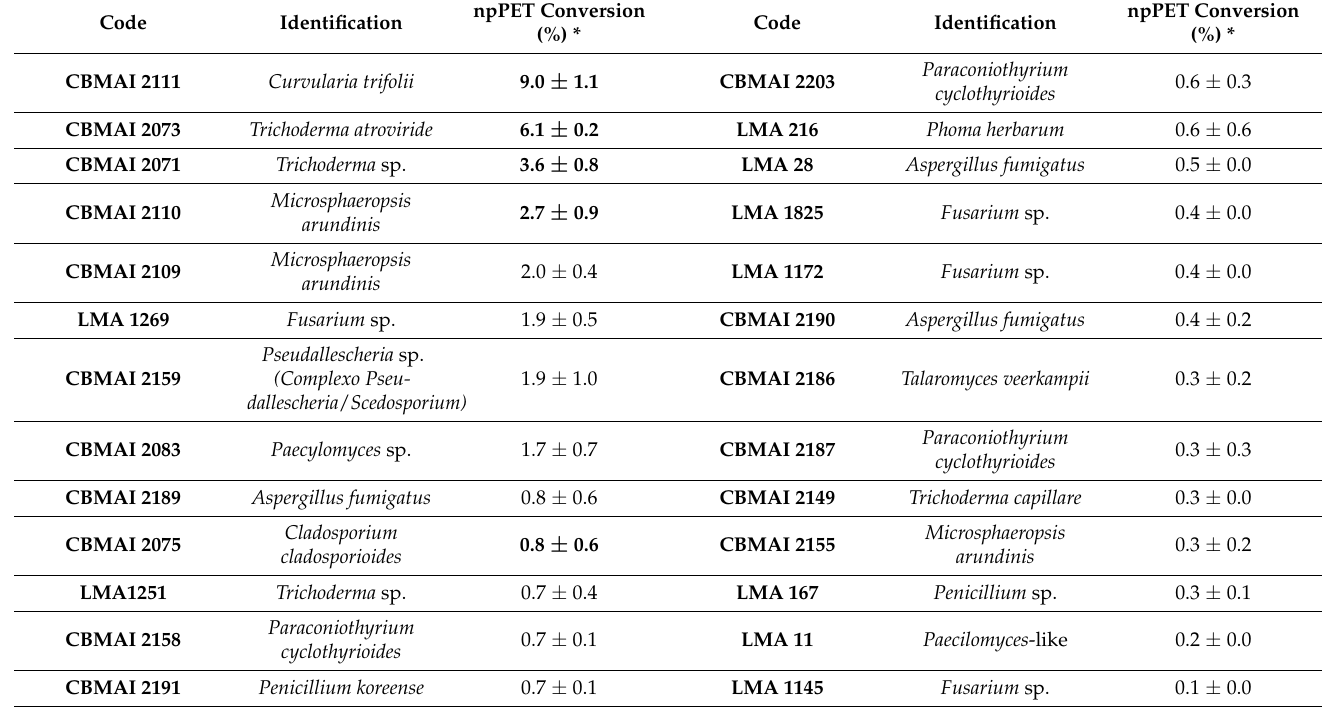
Table 5. PET nanoparticle conversion (%), results after fifteen days of